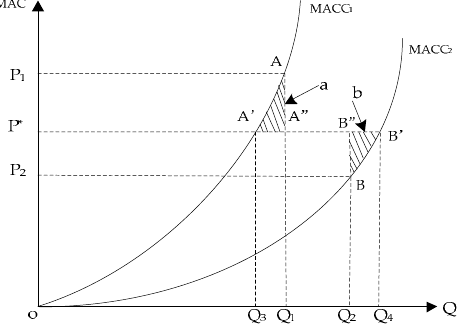
Figure 2. Marginal abatement cost curve.